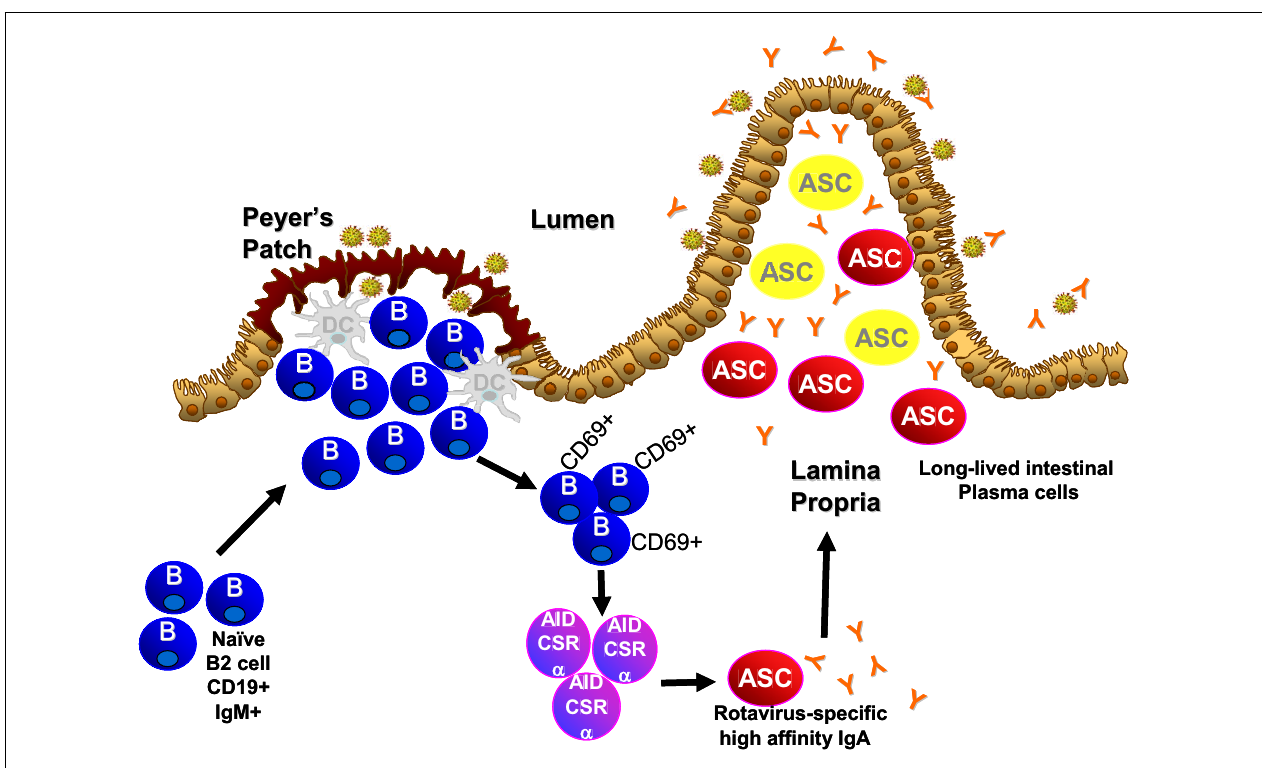
FIGURE 1 | Novel pathway of IgA induction and longevity in the intestine